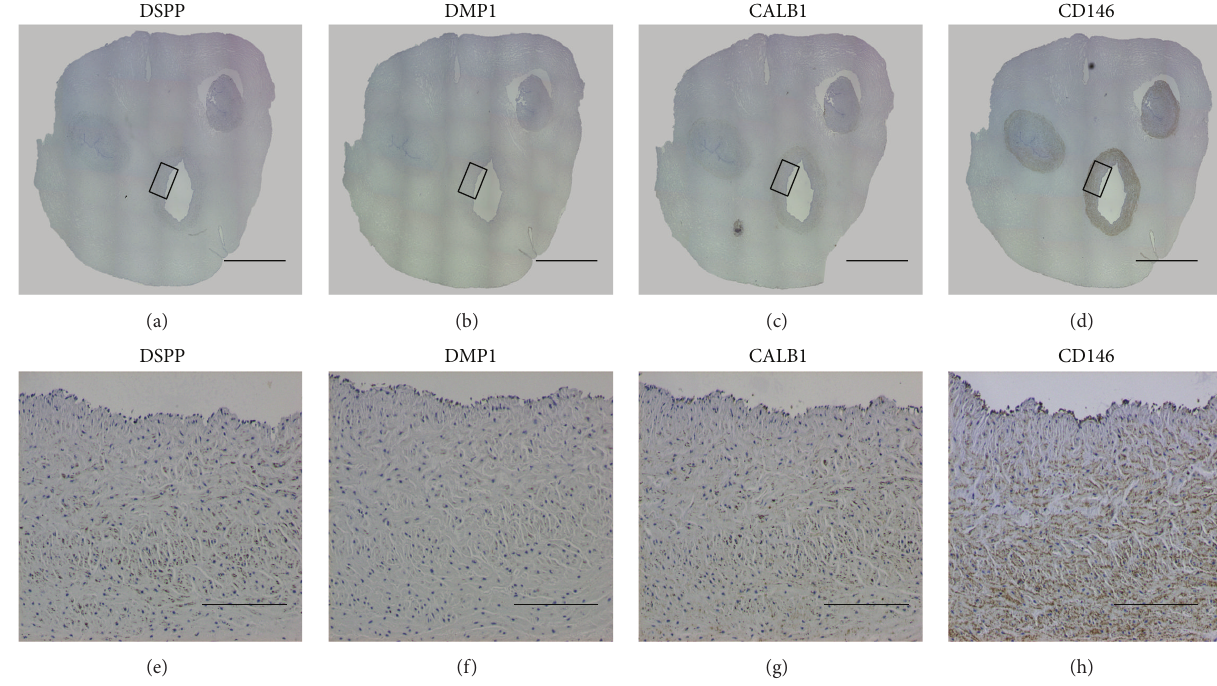
Figure 3: Immunohistochemical (IHC) staining of umbilical cord tissues. IHC staining for DSPP (a, e), DMP1 (b, f), CALB1 (c, g), and CD146 (d, h). CD146 is expressed on arteries of the umbilical cord, suggesting that the majority of stem cells arise from the microvasculature. (scale